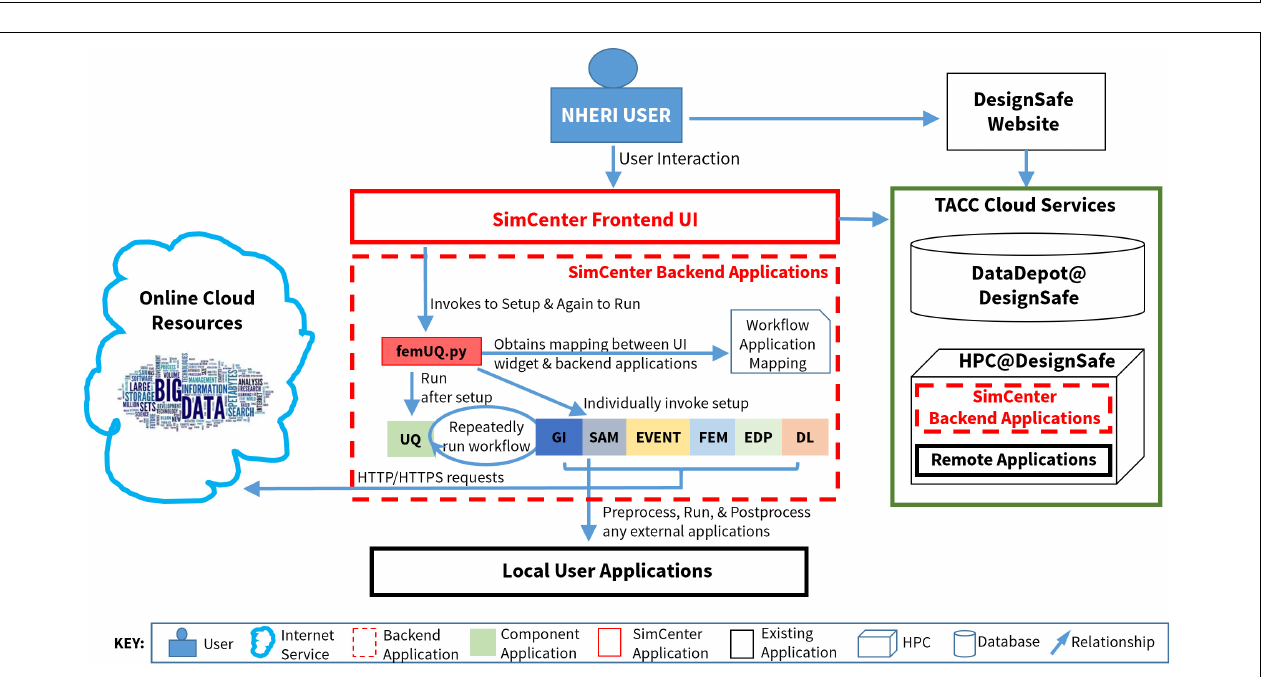
FIGURE 5 | Integration of the SimCenter framework into the NHERI computational